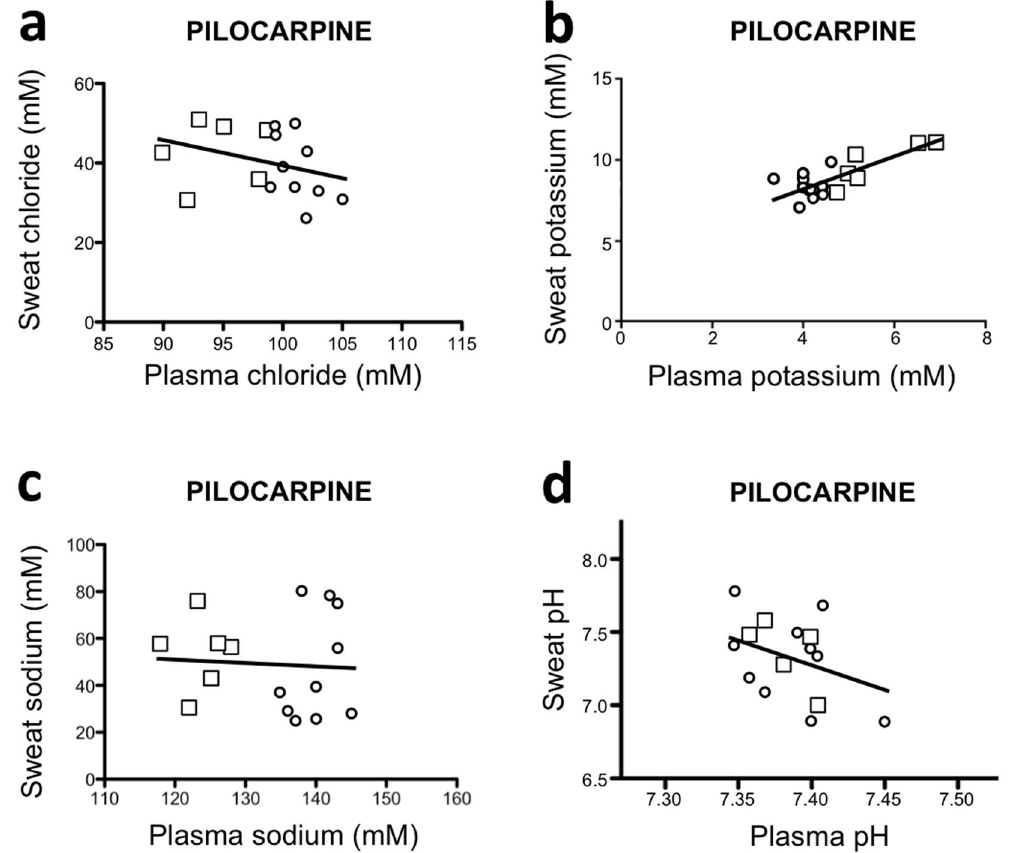
Figure 2. Relationship between electrolyte levels or pH in blood and sweat produced following pilocarpine iontophoresis. Sweat production was obtained using pilocarpine iontophoresis via the Macroduct TM system. Blood samples (3 mL) were obtained following venous puncture. Sweat samples (90 microL) were collected (healthy = small circle; patient = small square). Levels of chloride ( a ), potassium ( b ) and sodium ( c ) as well as pH ( d ) were measured using a Cobas TM 8000